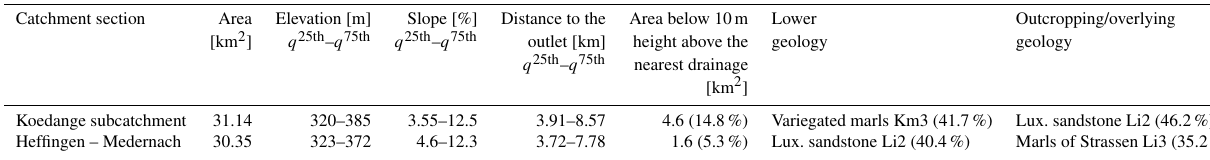
Figure 1. Ernz Blanche catchment (102km 2 ). Discharge and rainfall monitoring network; left: geological characteristics (see Kausch and Maquil, 2018 for more details). Right: topographical properties: slopes and height above the nearest drainage (HAND, Nobre et al., 2011). The Koedange subcatchment (KOE) and Heffingen–Medernach section (HM) are highlighted with orange and green contours, respectively. Table 1. Properties of the Ernz Blanche catchment by